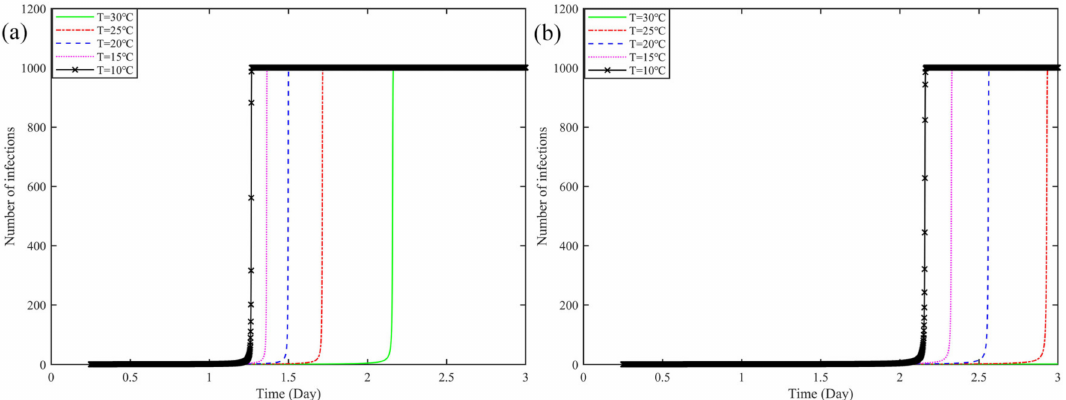
Figure 1. Effect of temperature change on virus transmission on express boxes: (( a ) Unsterilized, ( b ) Sterilized, and the subfigures show the lines represented by the different temperatures).